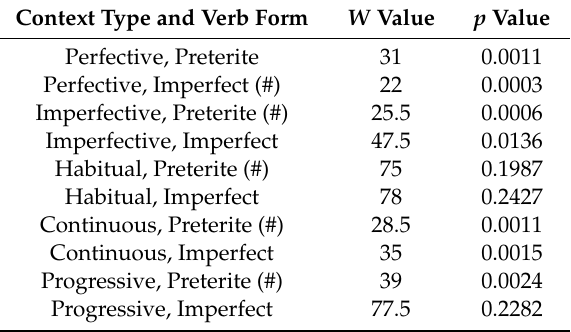
Table 4. Mann–Whitney (Wilcoxon) rank-sum tests for di ff erences between the parent and heritage speaker groups.